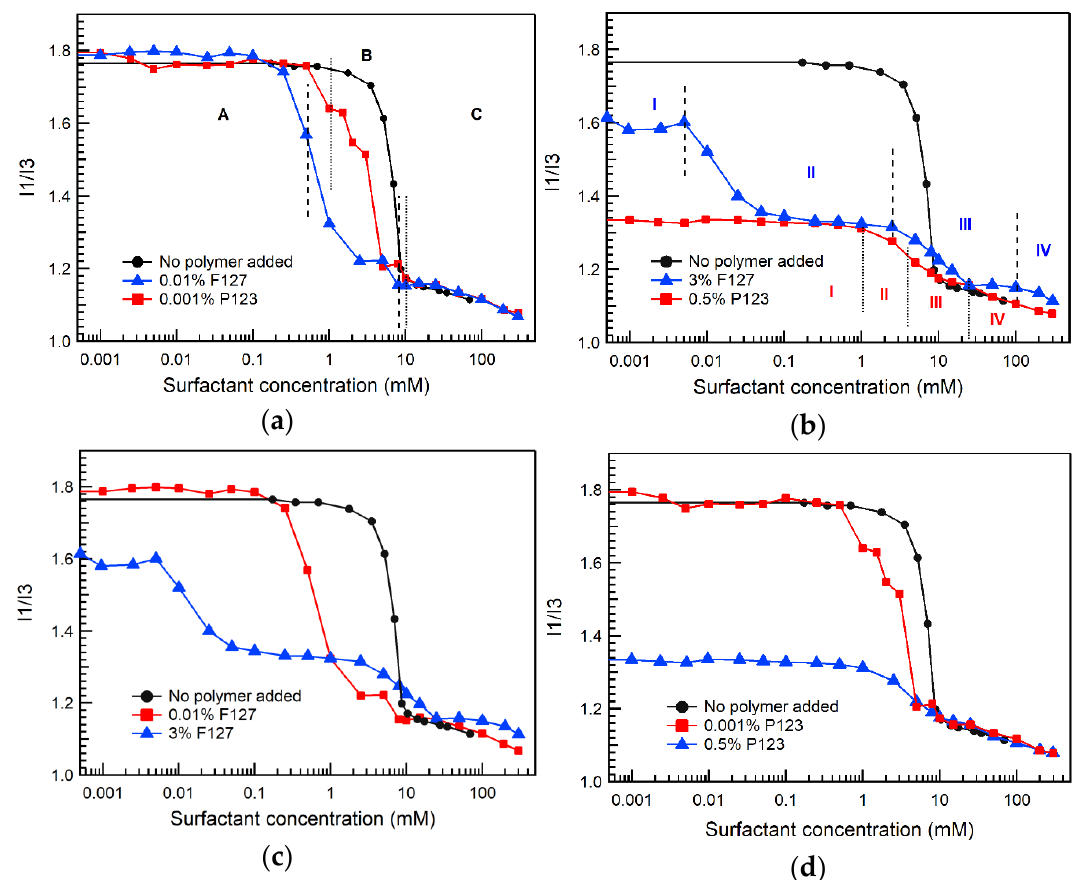
Figure 2. Pyrene fluorescence intensity I1/I3 ratio of SDS aqueous solutions in the absence and in the presence of 0.01% Pluronic F127, 3% Pluronic F127, 0.001% Pluronic P123, or 0.5% Pluronic P123, plotted as a function of SDS concentration (22 °C); ( a ) both Pluronics below their CMC; ( b ) both Pluronics above their CMC; ( c ) Pluronic F127 systems; ( d ) Pluronic P123 systems. The vertical dotted lines indicate SDS concentration regions that correspond to different stages of PEO-PPO-PEO block copolymer and ionic surfactant interactions, as described in the Results and Discussion Section and depicted in Figure 6.